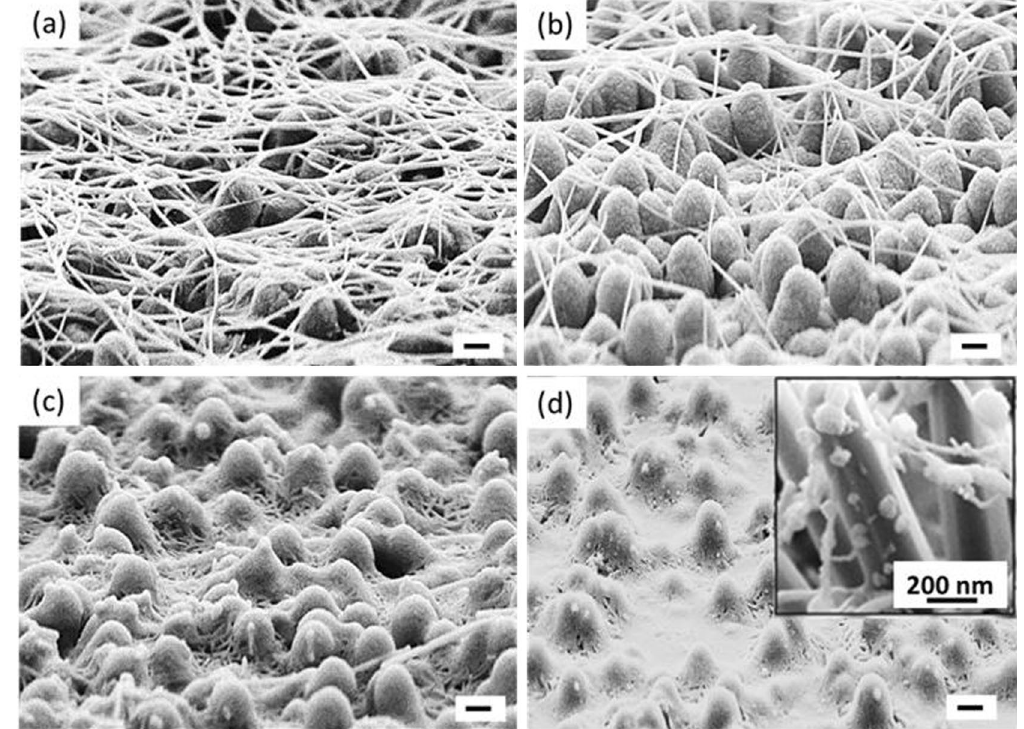
Figure 3. SEM images of Ag NWs coated on 3-D hybrid NWSCs using the same Ag NW coating density (2 × ) at annealing temperatures of ( a ) 120 °C, ( b ) 140 °C, ( c ) 200 °C, and ( d ) 240 °C. Inset of ( d ) shows a magnified SEM image of disconnected droplets of Ag on the sidewall of a 3-D nanowire after the anneal. The scale bar is 1 µ m unless otherwise labelled.